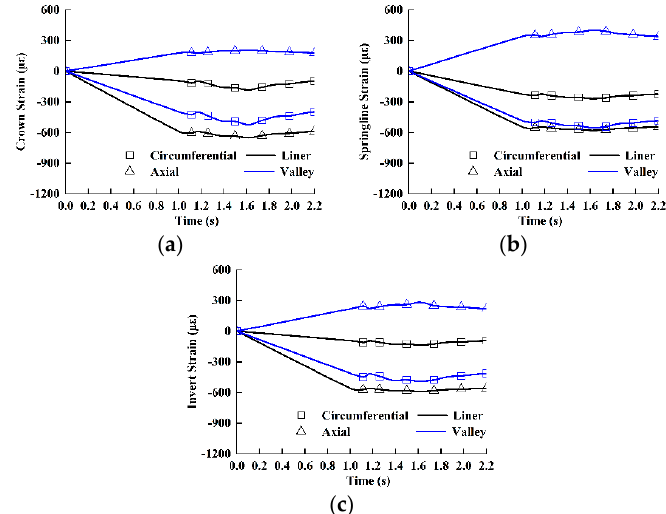
Figure 26. The measurements of pipe strain under traffic load: ( a ) the crown; ( b ) the springline; ( c ) invert.